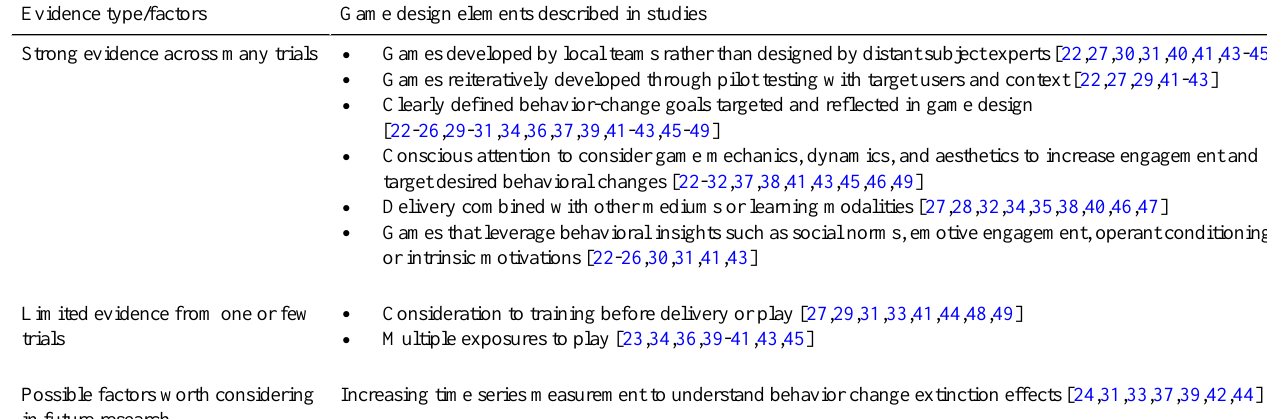
Table 1. Contextual and mechanism factors that enhance efficacy of games in behavior change. Game design elements described in studiesEvidence